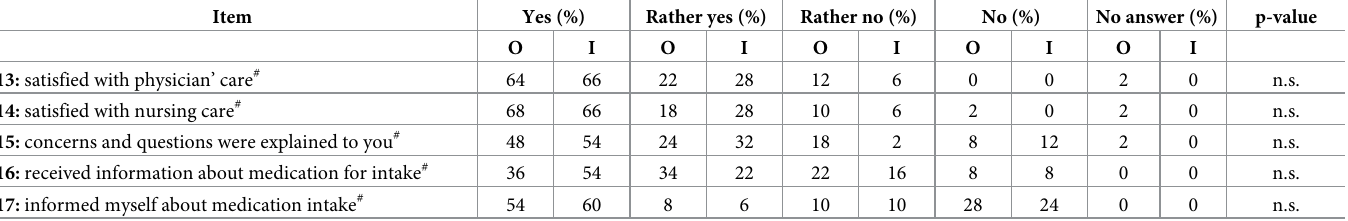
Table 3. Therapy associated satisfaction (group I = insulin; group O = oral antihyperglycaemic agent). Differences were calculated between both groups (O/I), dura- tion of diabetes (D), age (A), gender (G) and education level (E). Any significance is given in the column “p-value” (n.s. = not significant). Significant differences for dura- tion of diabetes, age, gender and education level are indicated in the description below the